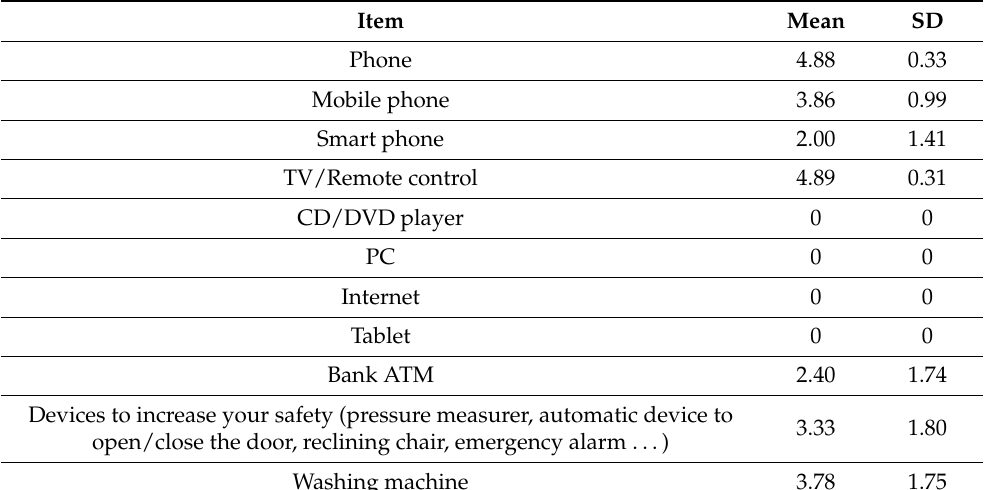
Table 1. Attitude towards technology in older users.